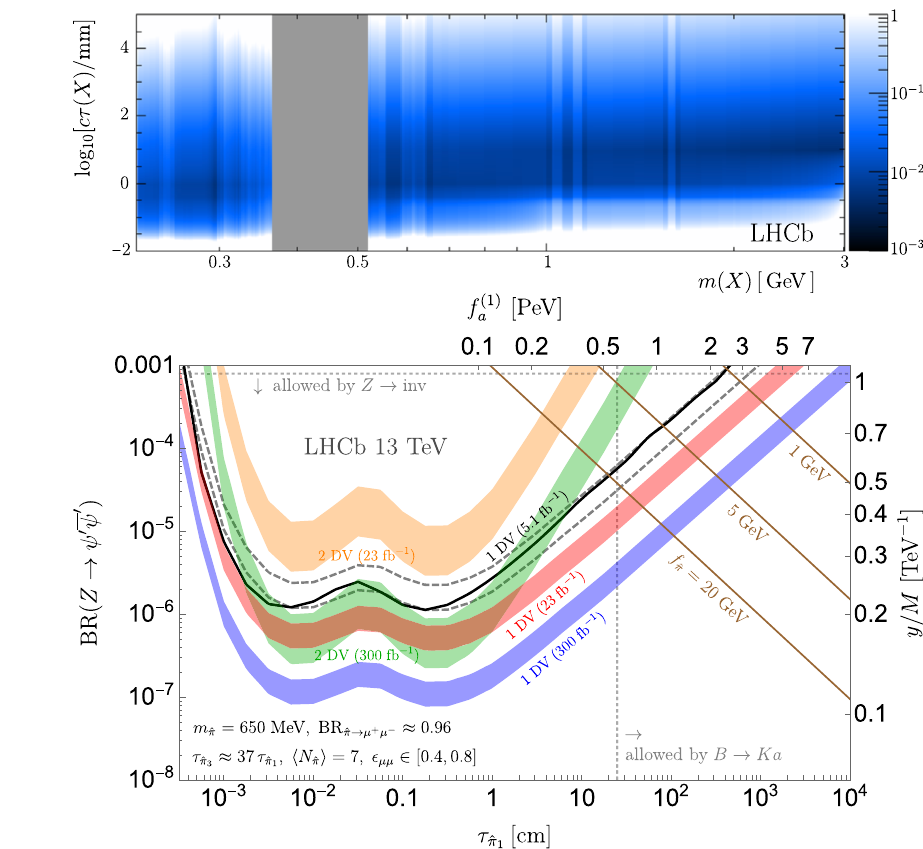
Fig. 13 Upper bounds at 90% CL on the kinetic mixing strength γ − Z HV . The grey box shows a vetoed region due to the large doubly misidentified K 0 background. Figure taken S from Ref. [102]